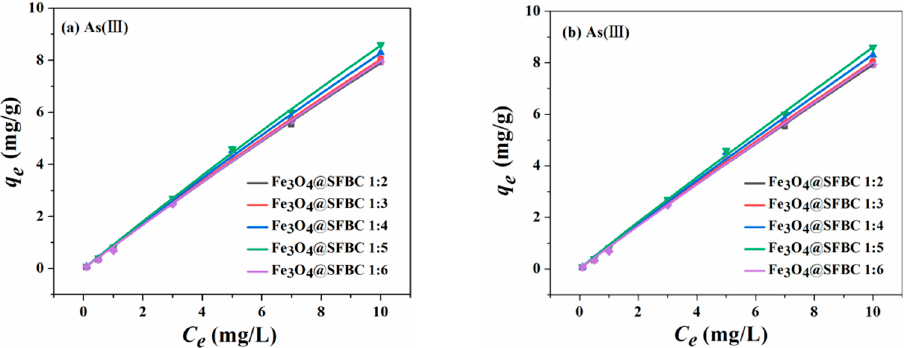
Figure 7. Adsorption isotherms of Langmuir ( a ) and Freundlich ( b ) on As(V) by Fe 3 O 4 @SFBC (prepared from biochar at different calcination temperatures) (experimental conditions: pH = 4, dose = 1 g/L, initial concentration = 0.1–10 mg/L, T = 25 °C).